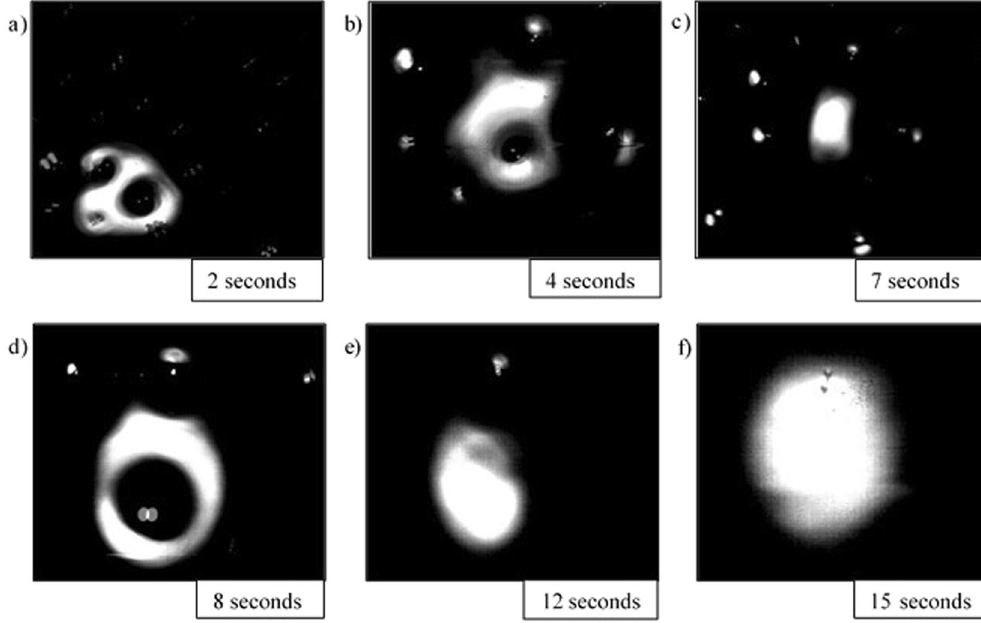
Figure 7. Time step images of the 2% FeAl experiment as seen in the HT-CSLM. In focus metal phases appear as lighter in grey scale and the molten metal oxide phase is seen as black. ( a–f ) Shows the cycle of perturbation growth to quiescent droplet.